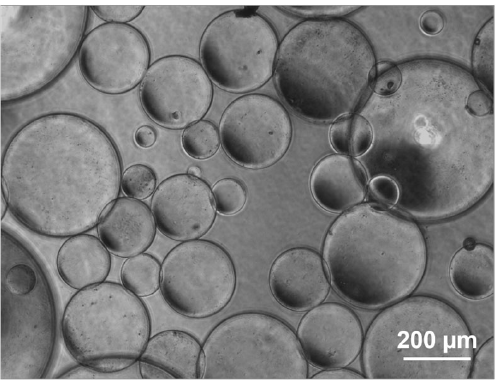
Figure 3. A representative image of DGL/PEG hydrogel microspheres. Illustration of the microsphere morphology obtained at a stirring speed of 1300 rpm. The spheres display different sizes, but the majority had a diameter of 200–300 μ m as illustrated under optical microscopy. Scale bar: 200 μ m.